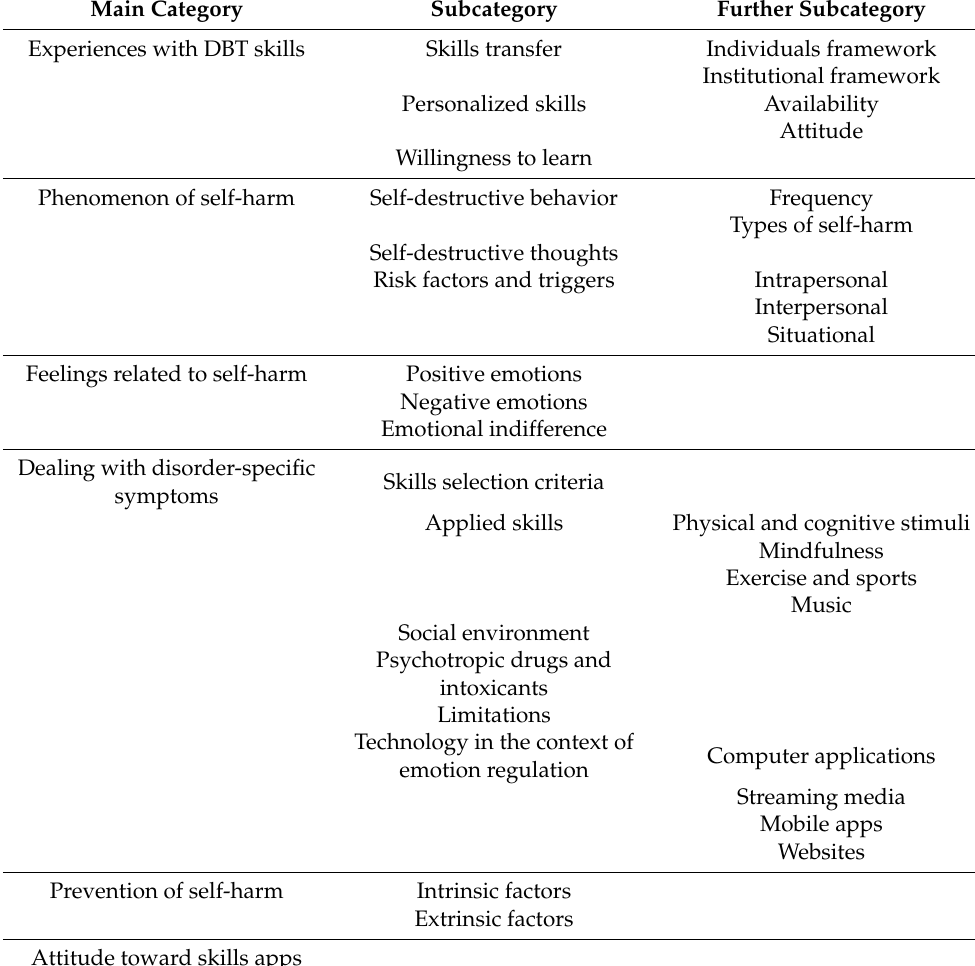
Table 1. Final category